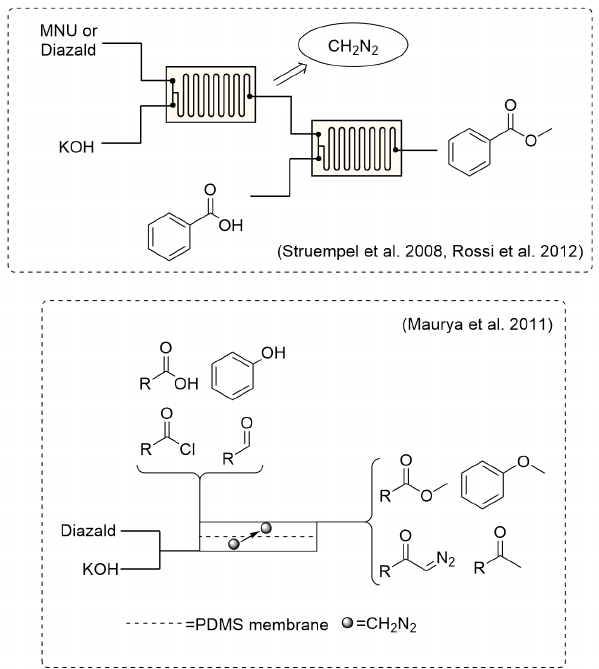
Figure 14 - In situ generation of diazomethane and dual-channel microreactor with membrane for diazomethane